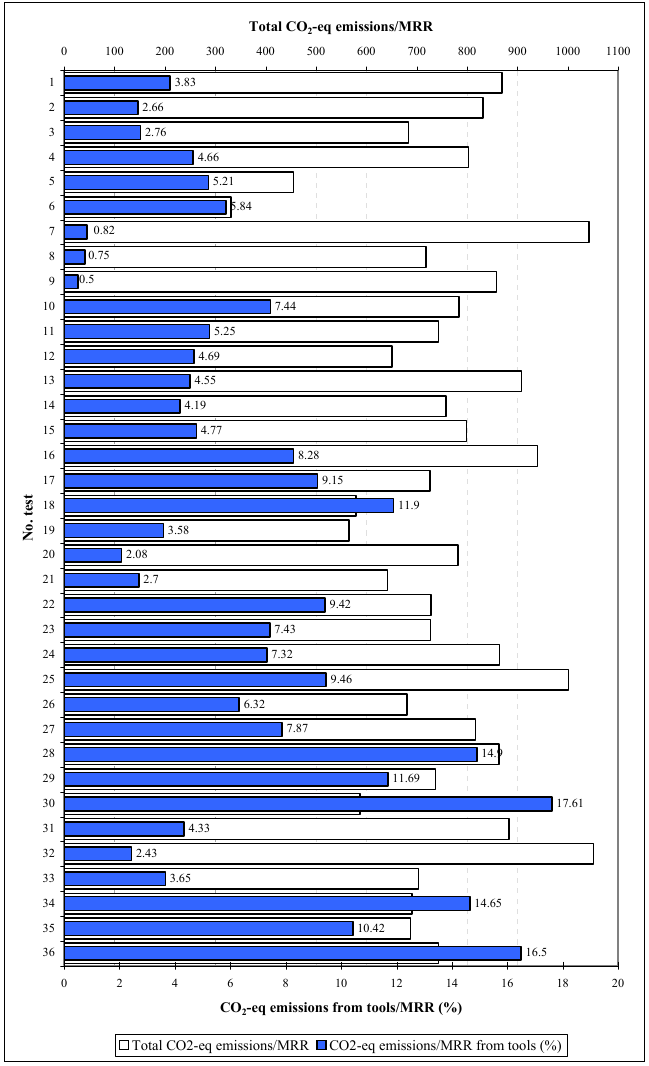
Figure 6. Contribution of tools to CO 2 -eq emissions/MRR as a percentage.